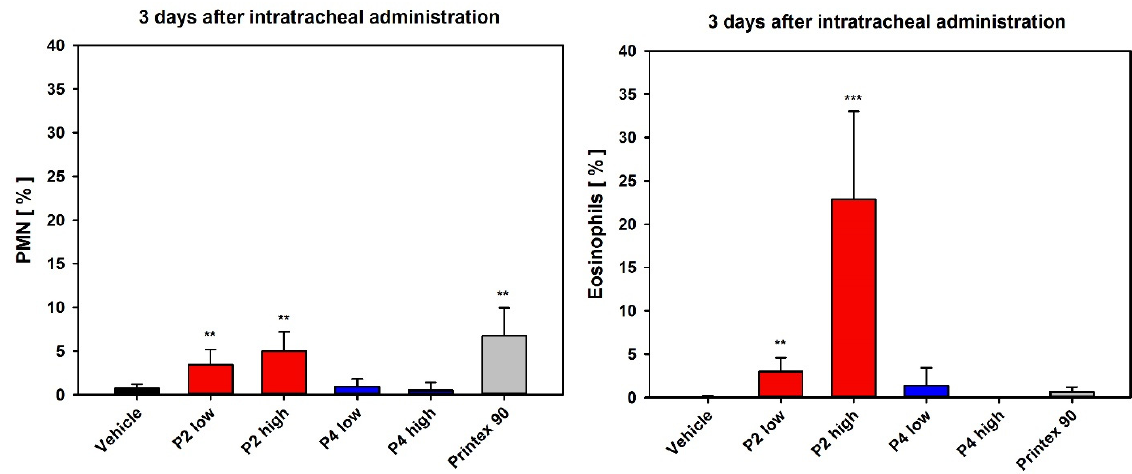
Figure 7. Differential cell counts 3 days after intratracheal instillation of P2 and P4. Note the high eosinophilic percentage, indicating a specific immunological response. Depicted are relative PMN and eosinophil numbers. Data represent means ± SD of four to five animals per group. **/*** Statistically significant difference from vehicle control (vehicle): p ≤ 0.01 or p ≤ 0.001, respectively; Student’s t -test for unpaired values, two-tailed.